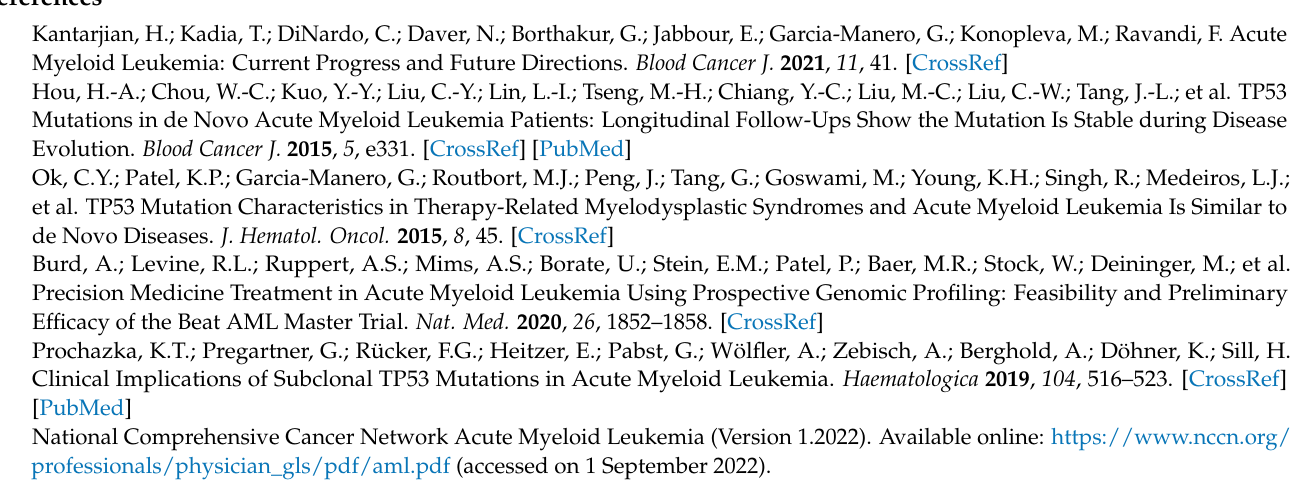
or decitabine in combinatorial